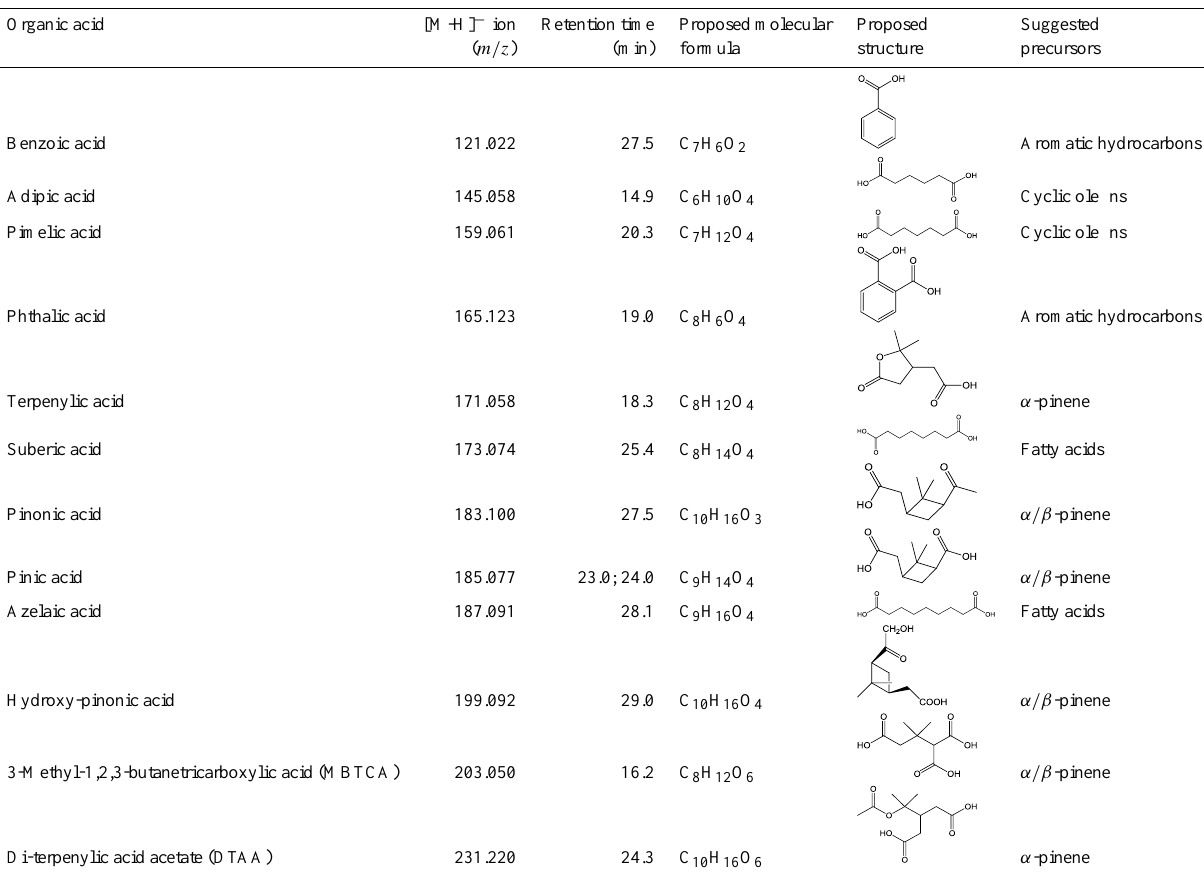
Table 1. Detected organic acids during the campaign. Related references on suggested precursors are cited in the text. Organic acid [M-H] − ion Proposed